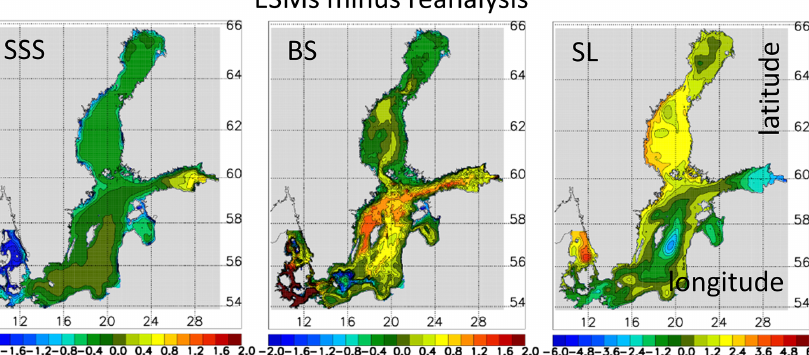
Figure 7. Upper panels: annual mean sea surface salinity (SSS) and bottom salinity (BS) (in gkg − 1 ) and the winter (December–February) mean sea level (SL; in cm) in the reanalysis data of 1971–1999 (Liu et al., 2017; from left to right). Note that the model results for sea level are given in the Nordic height system 1960 (NH60) by Ekman and Mäkinen (1996). Lower panels: difference between the climatologies of the ensemble mean of the regionalised ESMs used in BalticAPP (Saraiva et al., 2019a) during the historical period (1976–2005) and those of the reanalysis